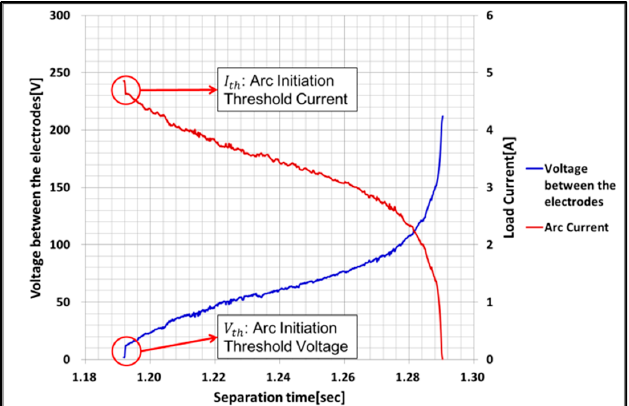
Figure 5. Experimental waveforms.